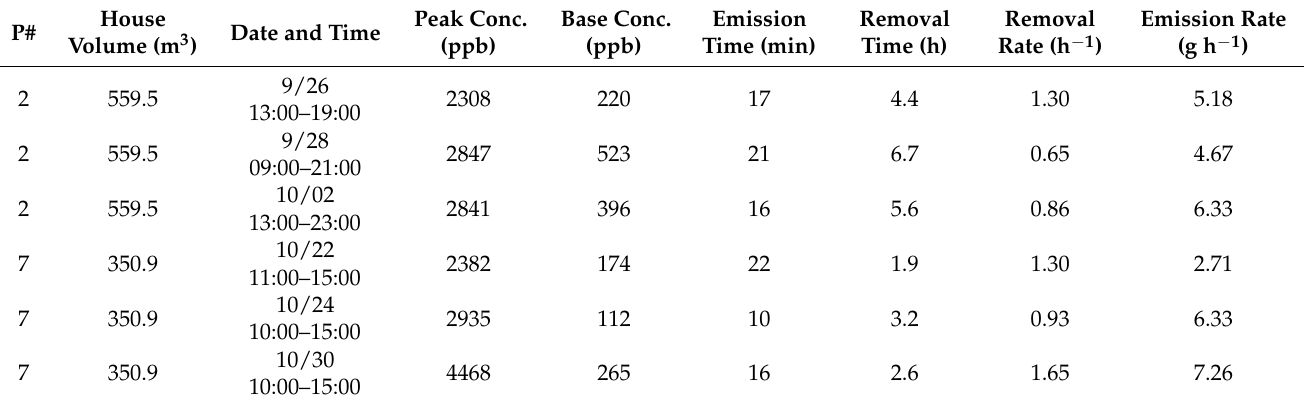
Table 1. Emission and removal rates for the Home-In